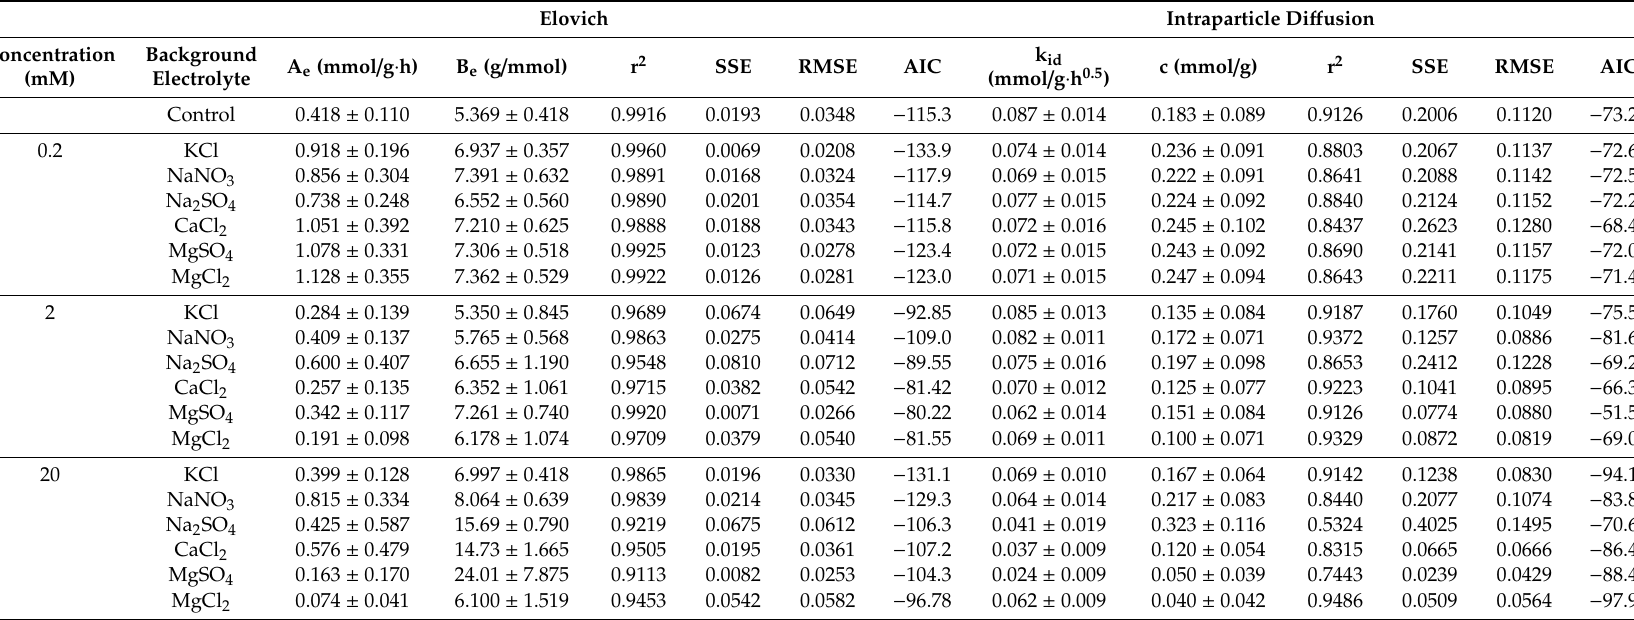
Table 5. Parameters of the Elovich and intraparticle di ff usion models for the biosorption of Ni 2 + by QCS at 0.2, 2, and 20 mM of background electrolytes. Elovich Concentration